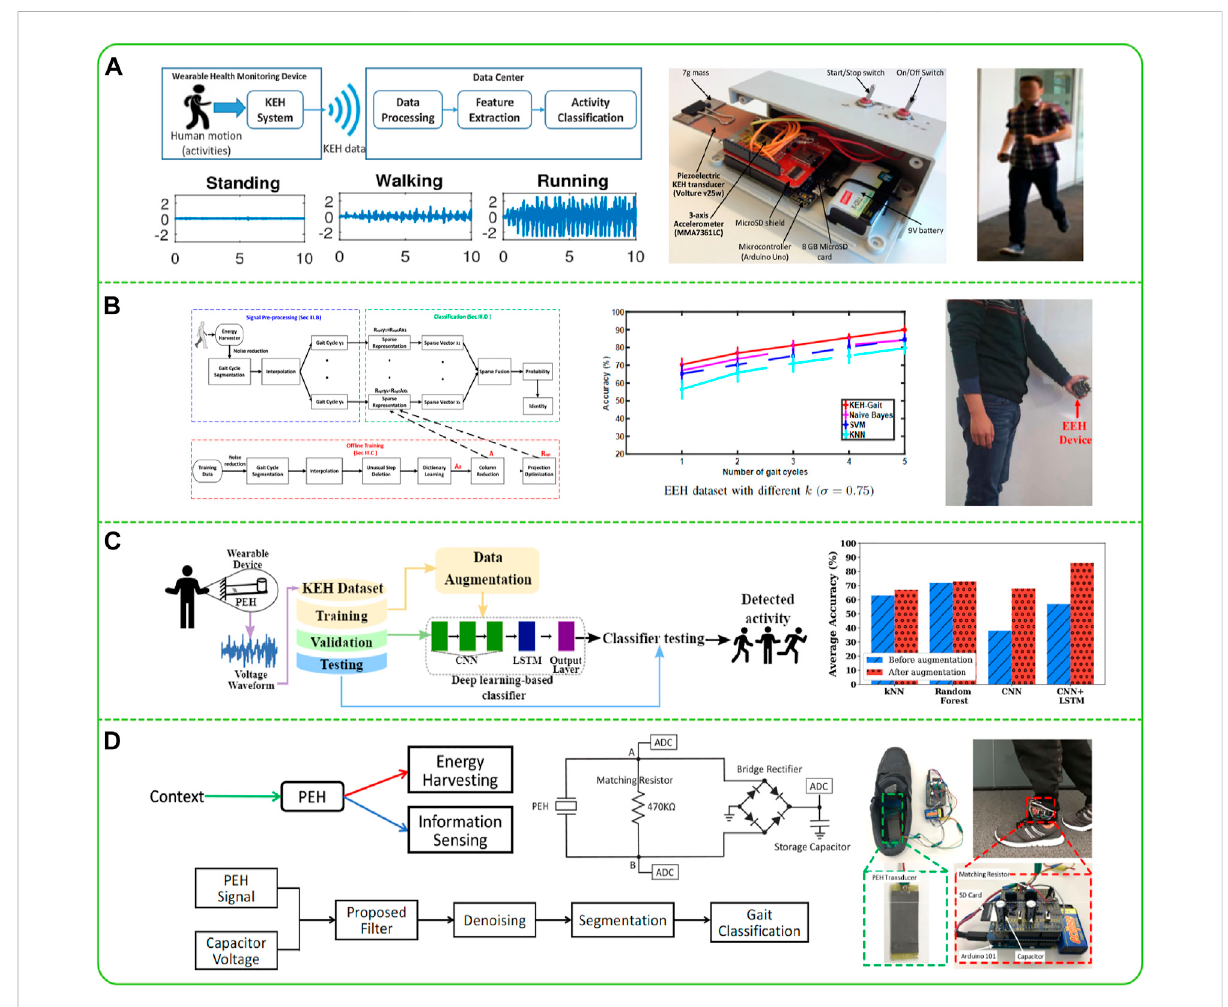
FIGURE 7 Piezoelectric and electromagnetic-based self-powered sensors. (A) Proposed architecture, sensing signals, prototype, and data collection process of HARKE (Khalifa et al., 2018). (B) System fl owchart of KEH-Gait, Comparison with classi fi cation methods on EEH dataset, photograph of EEH (Xu et al., 2019). (C) Pipeline of the proposed HAR system and the average accuracy before and after applying data augmentation on the piezoelectric-based training set (Manjarrés et al., 2021). (D) Proposed gait-recognition system using SEHS and the prototype of SEHS (Ma et al.,